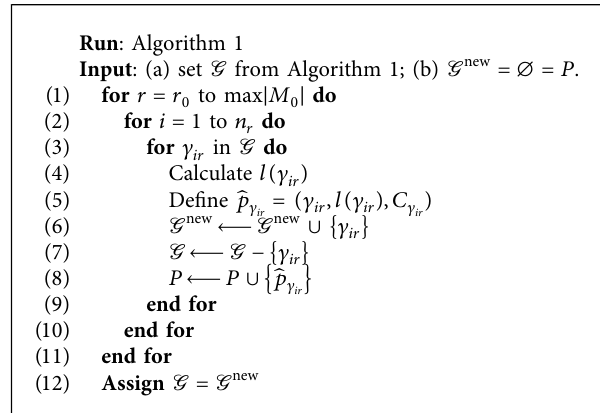
� r 0 . (b) Focus area with r 1 . (c) Focus area with multiple radii.